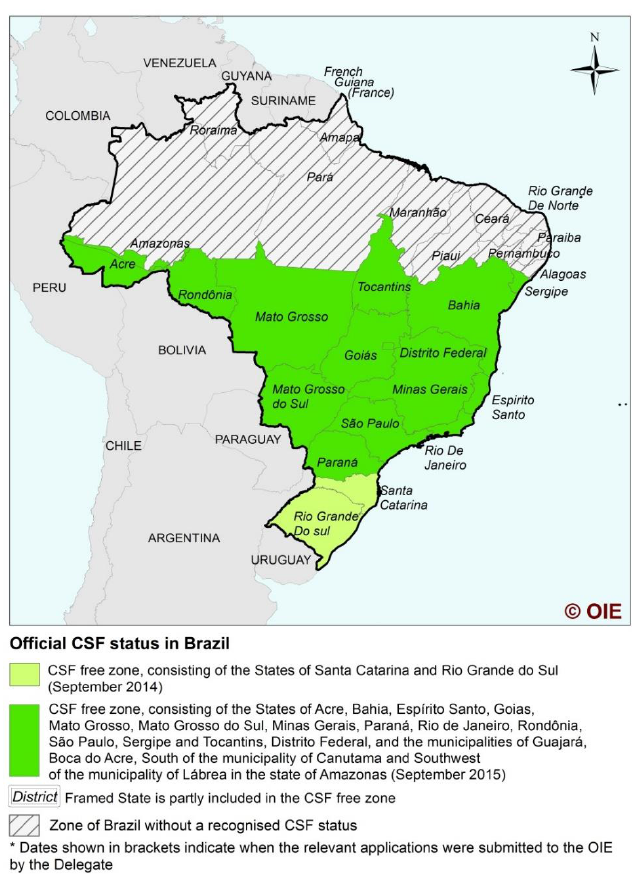
Figure 2. Classical swine fever-free zone in Brazil according to the World Organisation for Animal Health (OIE) [15].